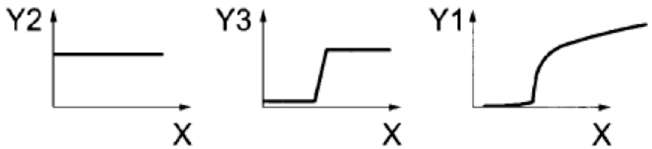
Figure 1. Principle of the Tensile Creep Test (TCT); where: X –time, Y1 –strain, Y2 –temperature, Y3 – stress,